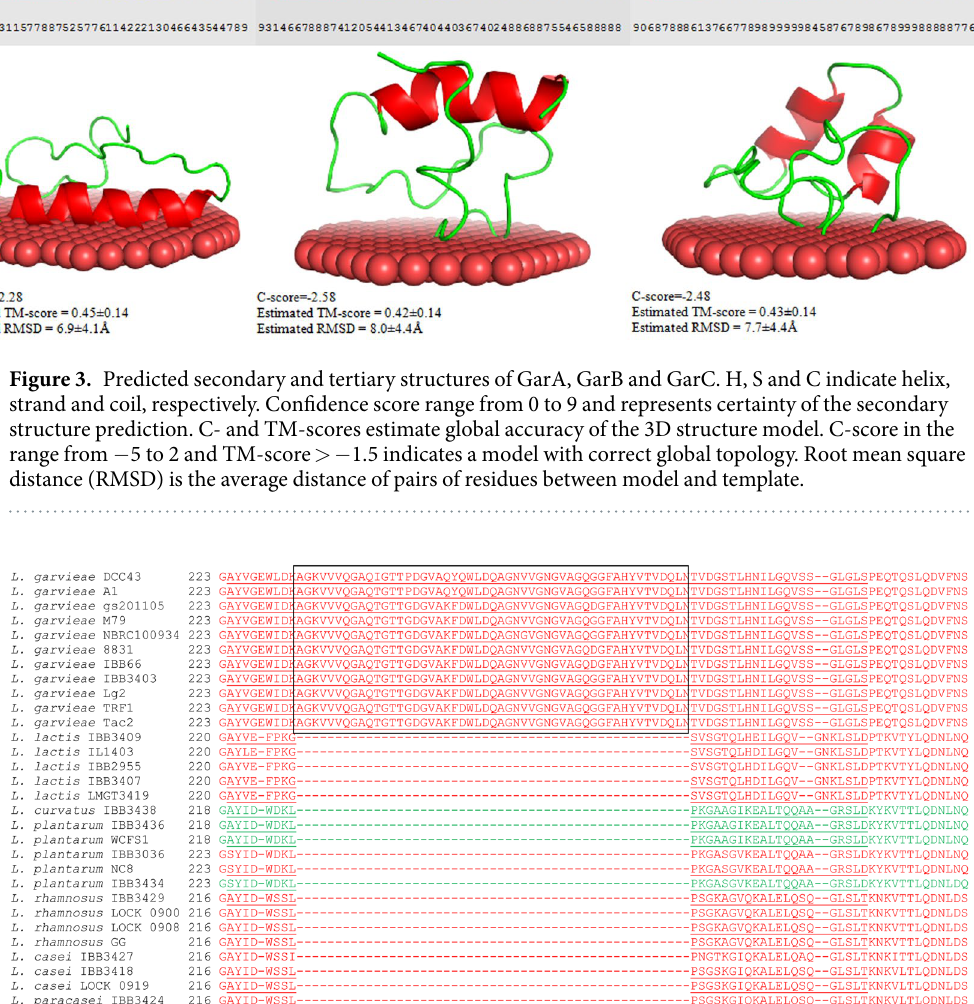
and 2-fold to GarA (same as for the LGA8 mutant). The remaining mutant (LGB6) also had a mutation in manD resulting in the Gln313 → Lys substitution in the extracellular loop of IID (Fig. 5). It was over 64-fold less sensitive to GarB and 2-fold to GarQ, and was fully sensitive to GarA (Table 1; Fig. 5). On man-CDM-GarC plates fifteen mutants were obtained (LGC1, LGC3-LGC6, LGC8, LGC9, LGC11-LGC13, LC15, LGC16, LGC18-LGC20) which were over 128-fold less sensitive to GarC than the parental L . garvieae IBB3403 (Table S1 in the supplementary file). They contained eight mutations, six in manD and two in manC . In most of the mutants the extracellular loop of the IID was affected by the following substitutions: Arg203 → Cys (LGC3-LGC6, LGC9, LC11, LGC20), Arg203 → Leu (LGC16), Tyr226 → Asp (LGC8), or Val315 → Met (LGC15). Other mutations in IID were in the N-terminal part and in the first transmembrane domain and comprised,